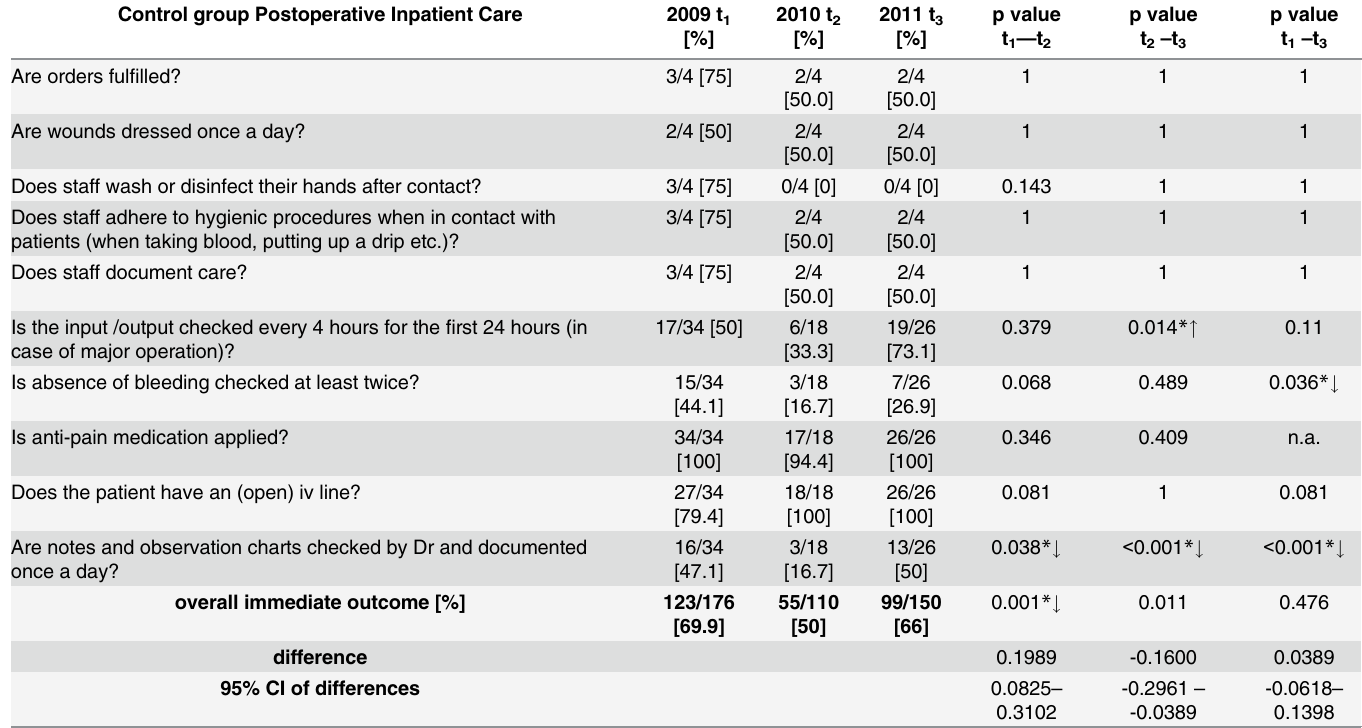
Table 7. Immediate outcome indicators for Postoperative Inpatient Care in the Control Group 2009 to